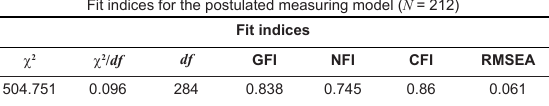
TABLE 4 Fit indices for the postulated measuring model ( N =